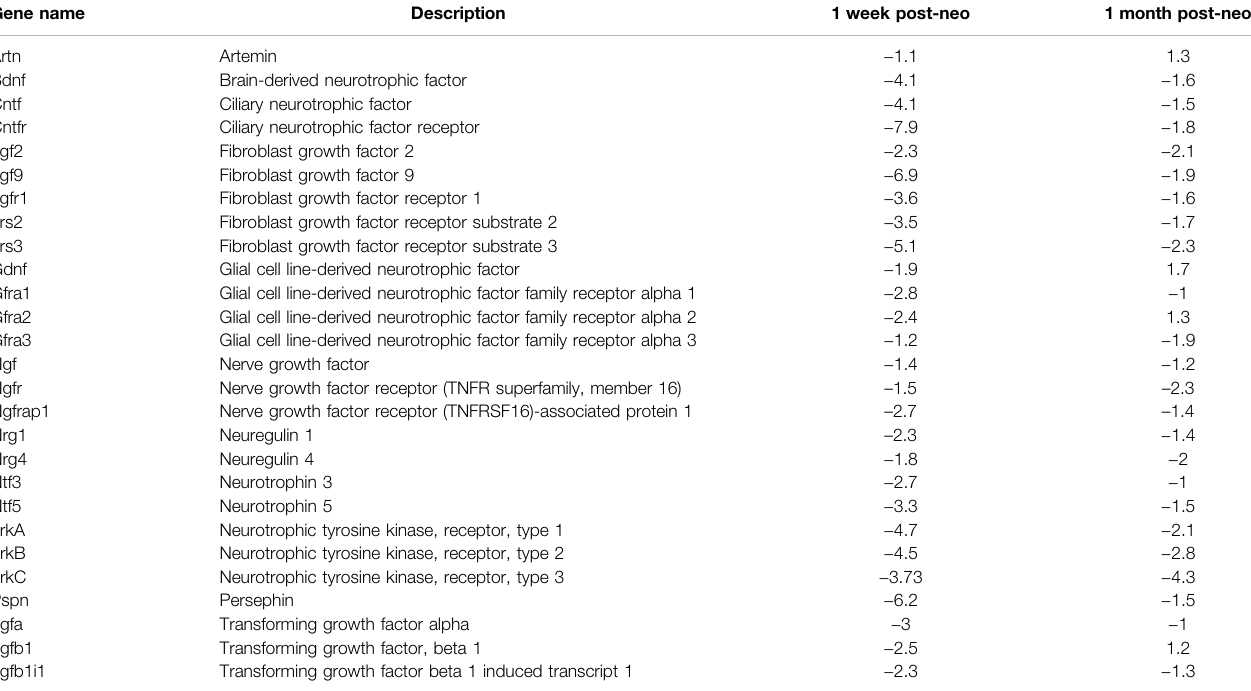
TABLE 2 | qRT-PCR evaluation of growth factor expression 1 week and 1 month after neomycin treatment. Results show expression relative to non-neomycin-treated